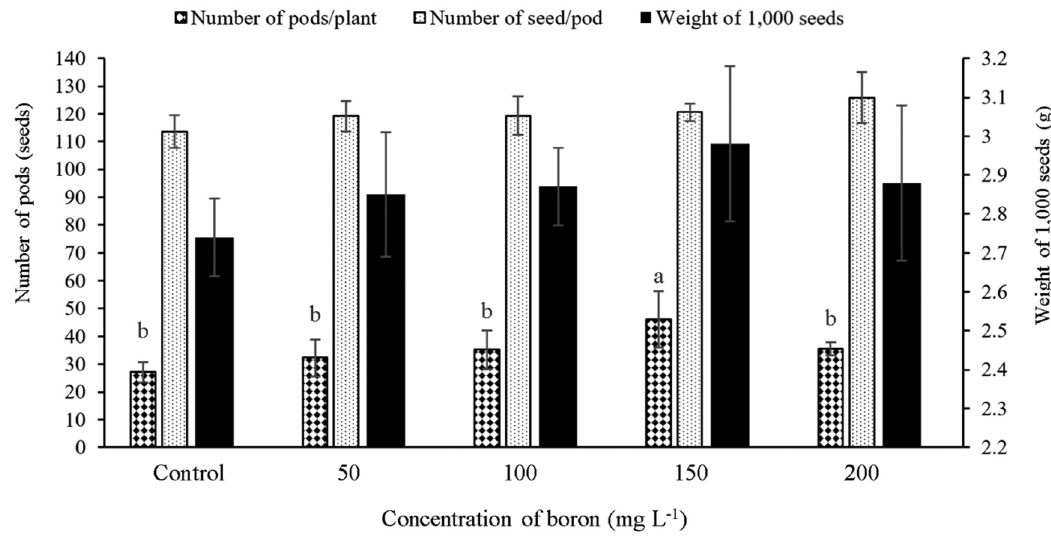
Figure 5: E ff ect of boron on number of pods per plant, number of seeds per pod, and weight of 1,000 seeds. Letters within the columns represent a signi fi cant di ff erence ( P < 0.05 )